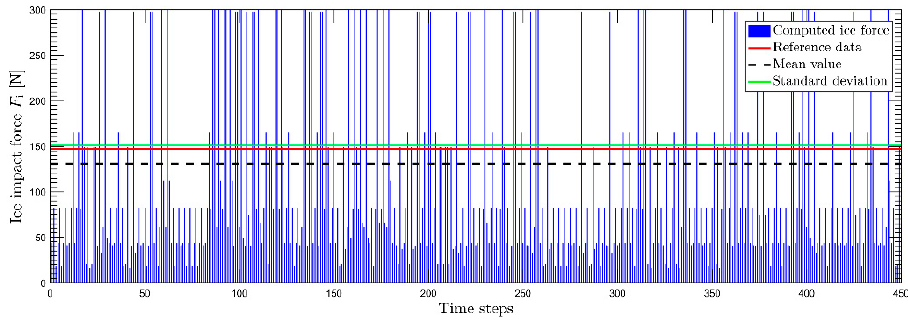
Figure 15. Case 2: Result comparison for speed V = 0.92 m/s .